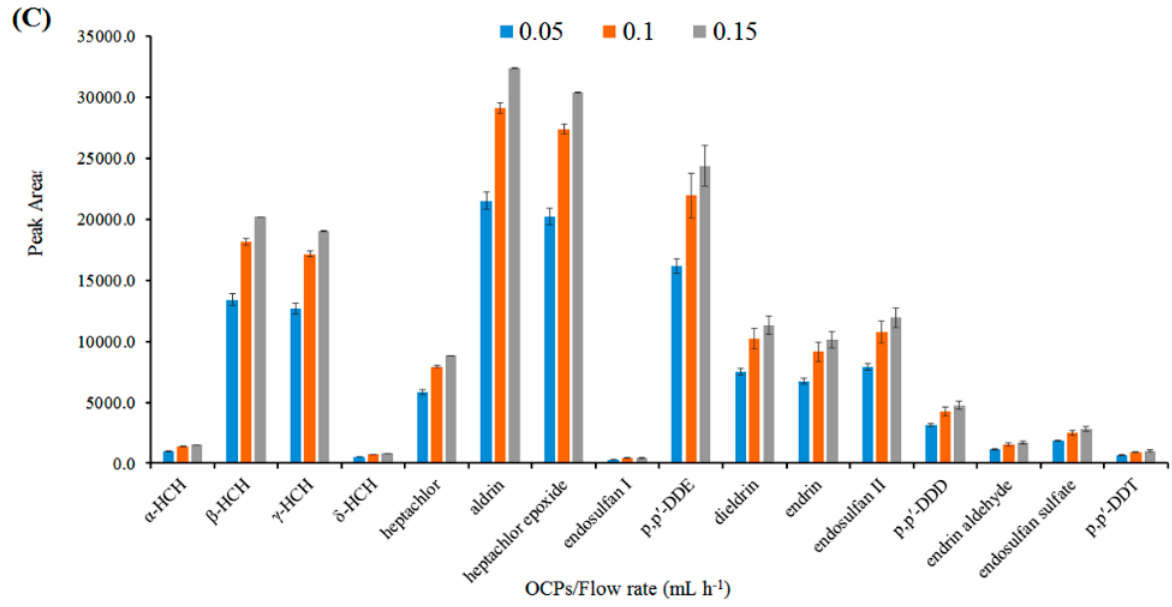
Figure 2. ( A ) Performance of different types of PET nanofibers, ( B ) dosage of nano-SiO 2 (mg) in PET nanofibers, and ( C ) the effect of polymer solution flow rate (mL h − 1 ).